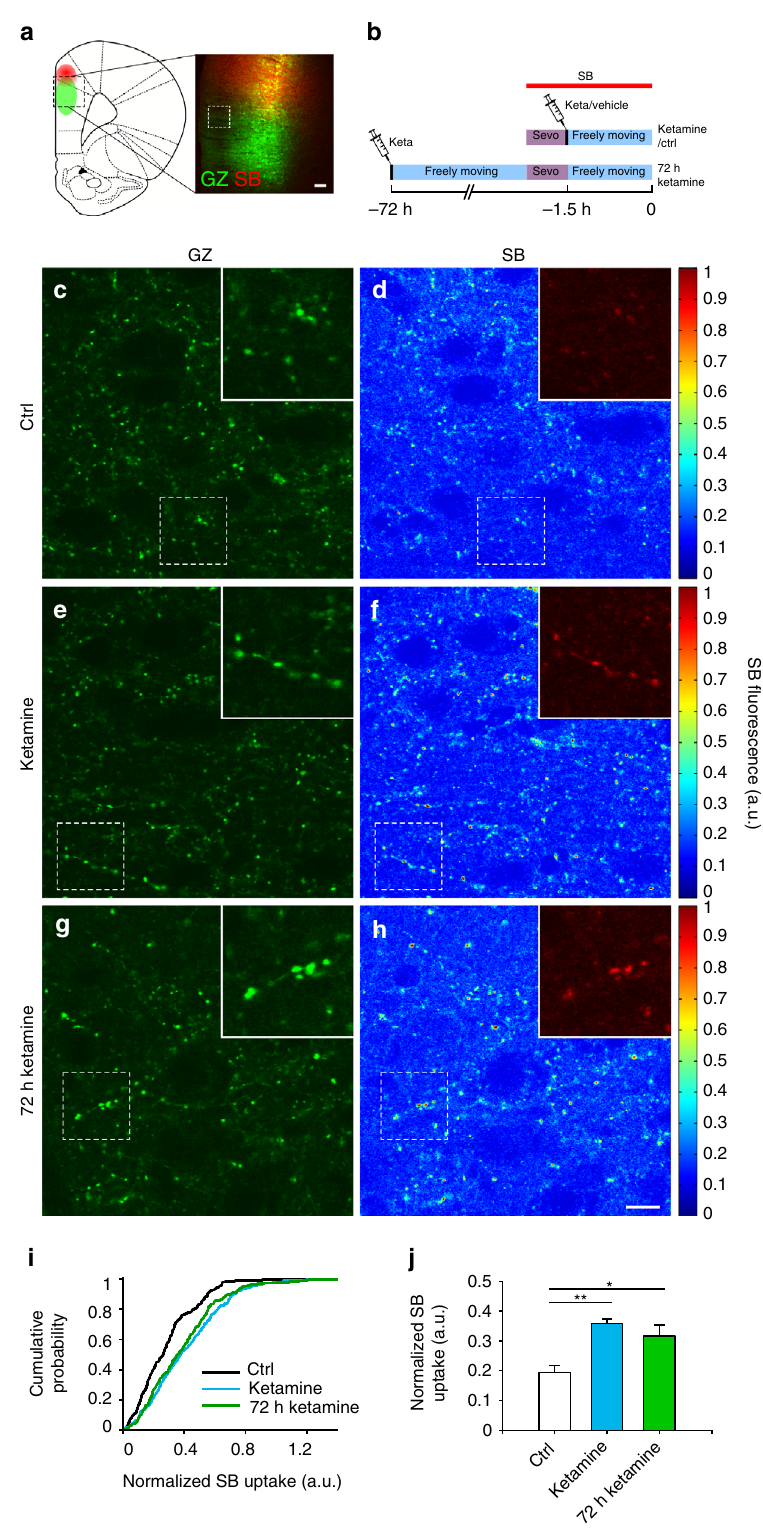
Fig. 5 SynaptoZip reveals that ketamine induces a rapid and sustained increase in the activity at mPFC synapses. a Illustration (left) and merged fl uorescent image (right) of the mPFC with the sites of GZ expression (green) and SB injection (red; dashed square indicates a typical fi eld for SB uptake analysis; see also Supplementary Figs. 6, 8). b Time fl owchart indicating SB delivery, ketamine treatments, and sevo fl urane anesthesia (Sevo). c – h GZ expression ( c , e